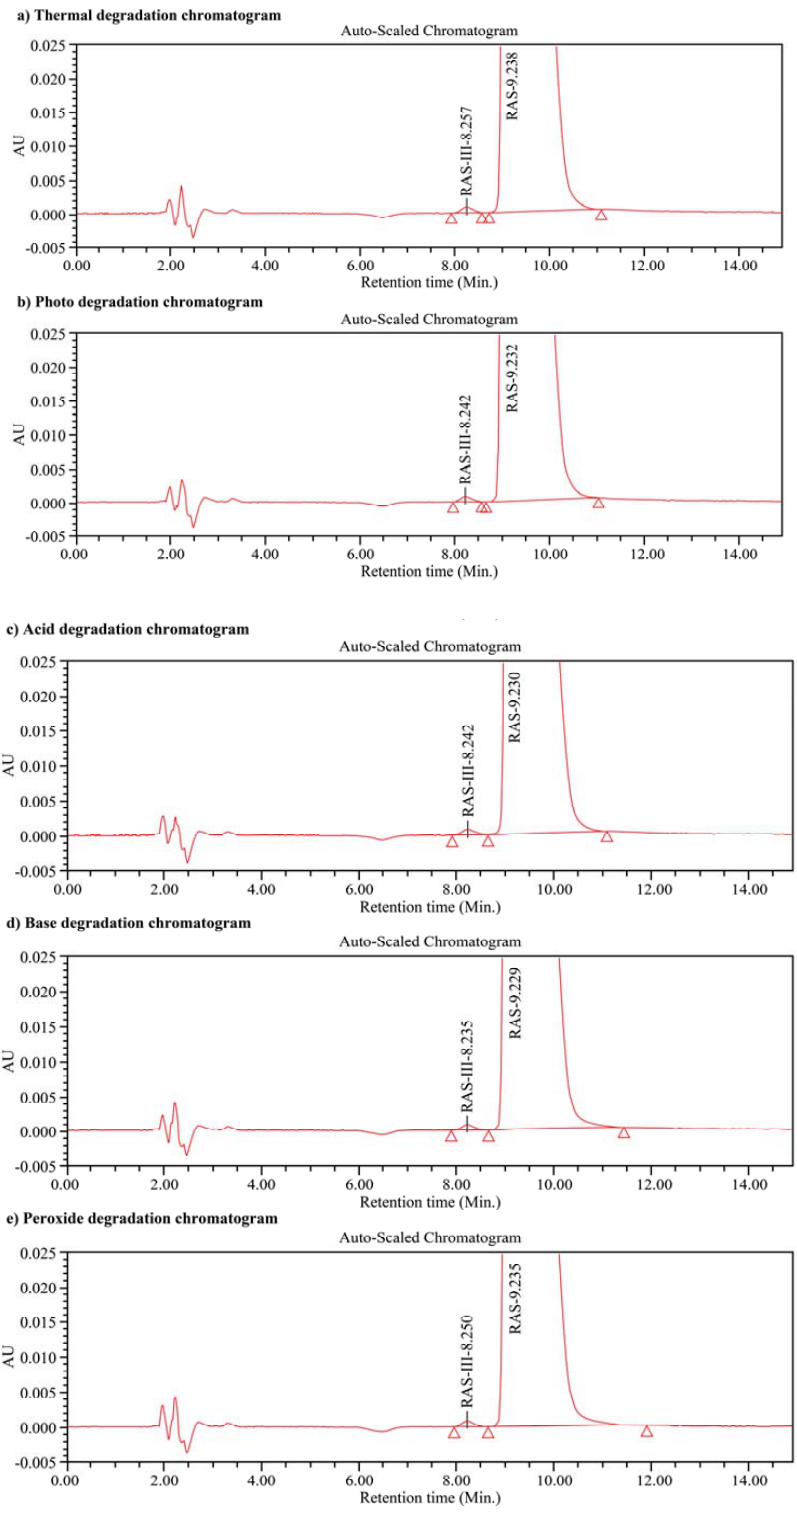
Figure 4. Chromatograms of ( a ) the acid degraded; ( b ) the base degraded; ( c ) the peroxide degraded; ( d ) the thermally degraded; and ( e ) the photodegraded solutions. RAS-III = S -enantiomer, RAS = R -enantiomer. Chromatographic conditions: Chiralpak ® AGP column (50 mm × 2.1 mm, 5 µ m); 90:10 ( v/v ) mixture of ammonium acetate and isopropyl alcohol as the mobile phase; 0.6 mL/min flow rate; 210 nm detection wavelength; and 2.0 µ L injection